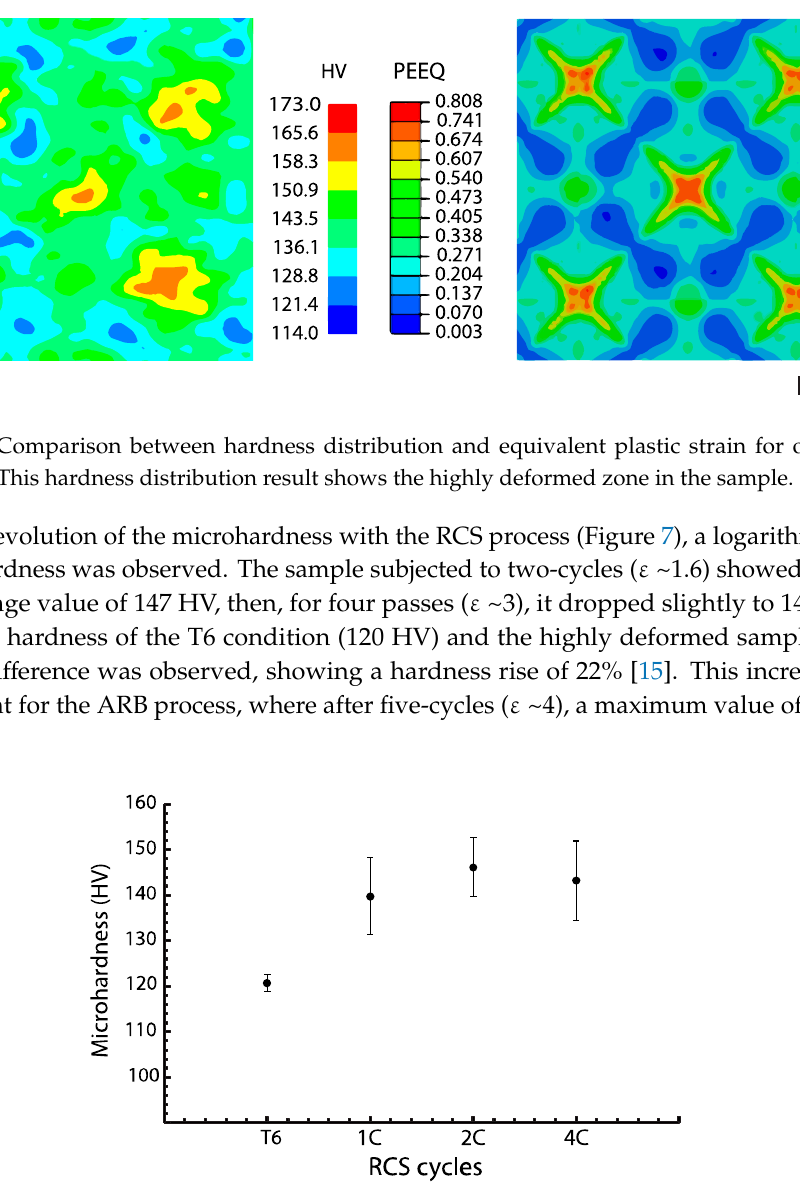
Figure 7. Evolution of the Vickers Microhardness as a function of the RCS cycles, a logarithmic behavior is clearly observed.